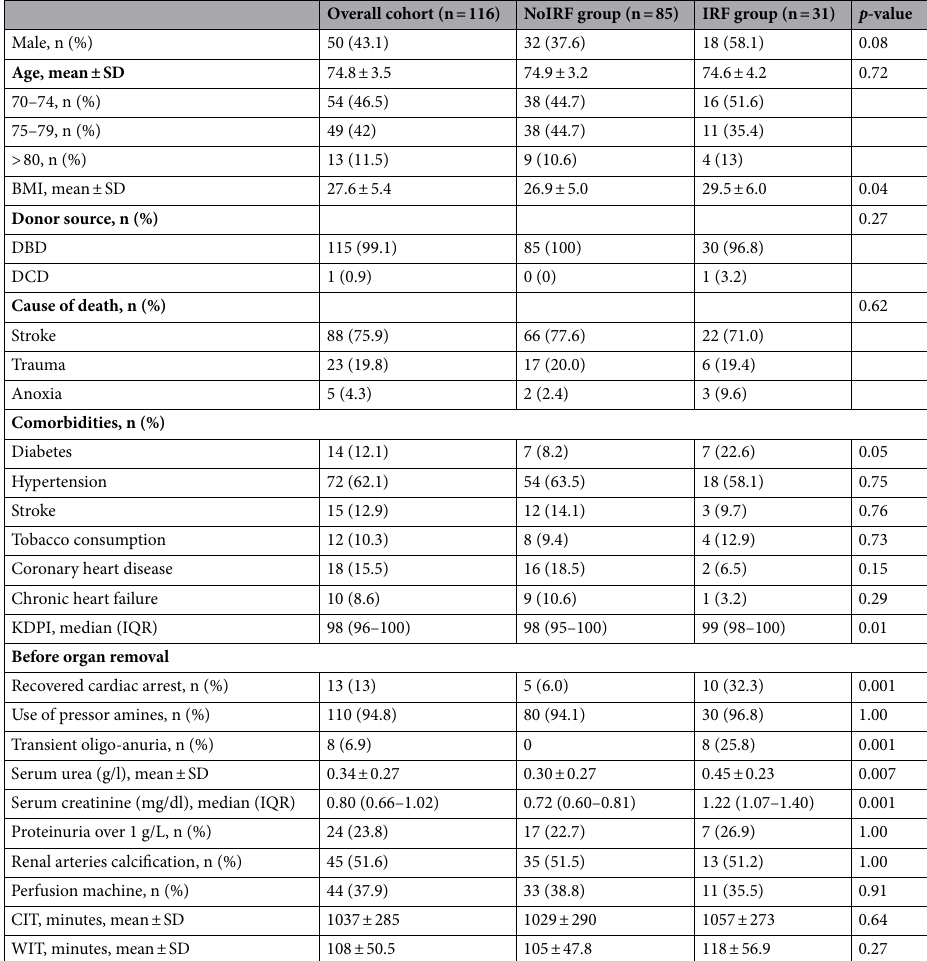
Table 1. Baseline donors’ characteristics with comparison according to a peak serum creatinine over 1.0 mg/ dl and/or a transient oligo-anuria in the donor. For all tests, a p-value < 0.05 was considered as significant. BMI Body Mass Index, DBD brain deceased donor, DCD donor after cardiac death, CIT cold ischemia time, IQR interquartile range, KDPI Kidney Donor Profile Index, N/A non appliable, IRF Impaired Renal Function, SCr serum creatinine, WIT warm ischemia